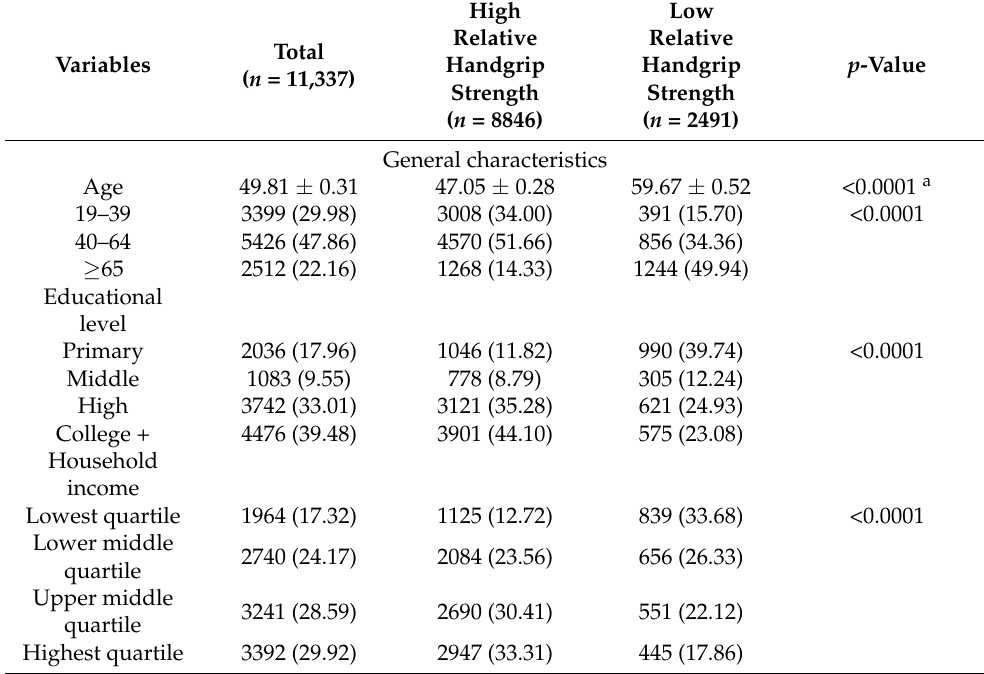
Table 1. General characteristics of the